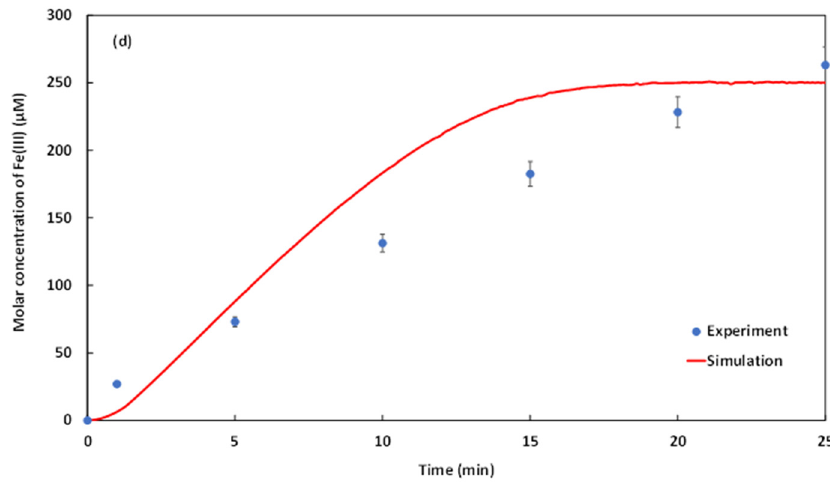
Figure 4. UV-vis spectra describing the kinetics of Fe(III) in the electrolyte obtained in the absence of the dye (a) and its corresponding comparison of experimental and simulated results (b) , and the presence of the dye at an initial concentra- tion of 5 mg ∙ L − 1 (c) with its corresponding comparison of experimental and simulated results (d) (pH 3 and 162 µM of added H 2 O 2.